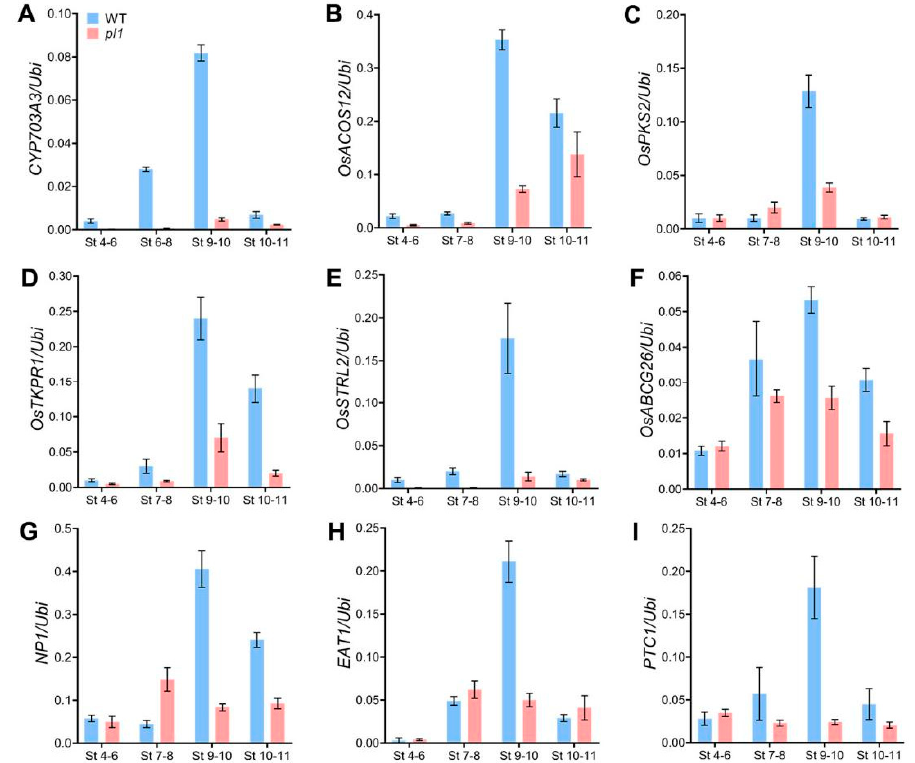
Figure 8. Expression profiles of genes related to anther and pollen development in WT and pl1 . Expression levels of CYP703A3 ( A ), OsACOS12 ( B ), OsPKS2 ( C ), OsTKPR1 ( D ), OsSTRL2 ( E ), OsABCG26 ( F ), NP1 ( G ), EAT1 ( H ) and PTC1 ( I ) in spikelets with anthers at different stages (St) were analyzed using qRT-PCR. Data are shown as means ± SD (n = 3).